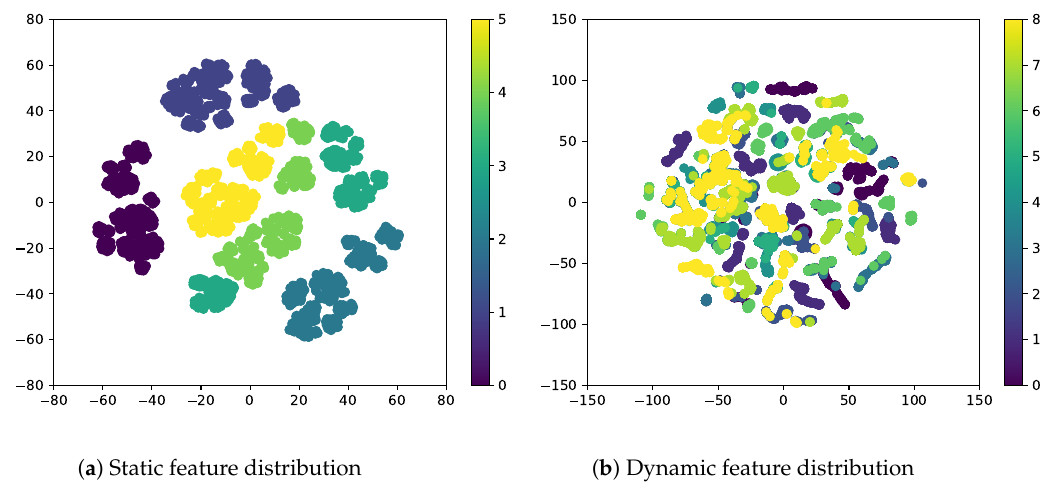
Figure 2. Disentangled sequential variational autoencoder (DSVAE): visualization of ( a ) static and ( b ) dynamic features in the latent spaces on the Sprites dataset using t-SNE [27]. The static features are separately distributed for each class, whereas the dynamic features overlap across the classes.